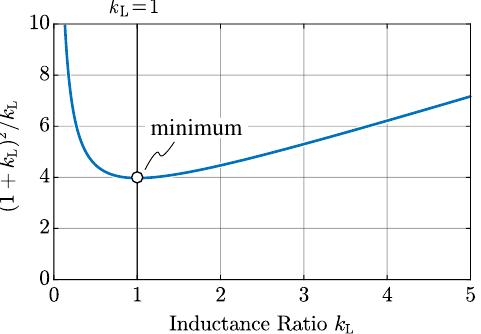
Figure 5. Asymptotic filter admittance trend ∝ ( 1 + k L ) 2 / k L as function of the inductance ratio k L